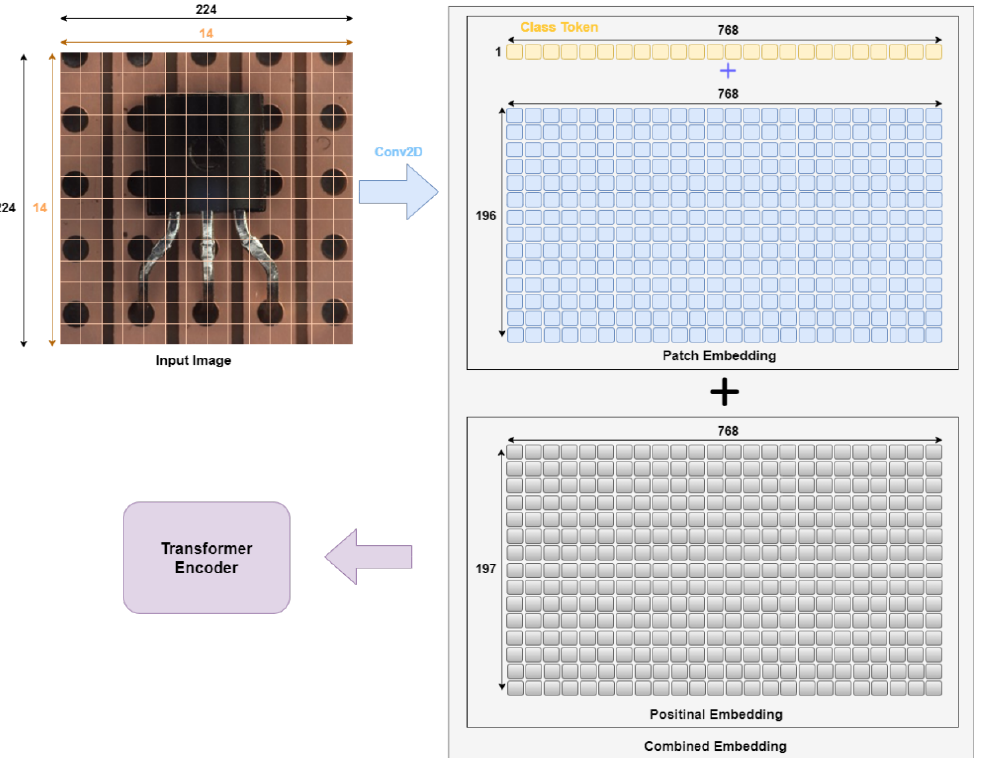
Figure 3. ViT embedding: if the input image size H, W is 224, and the channel number is 3, then the patch size is 16. When patch embeddings are applied, this is a sequence of 196 × 768 dimensions of the tensor. Subsequently, if a class token is added, it has a sequence of 197 × 768. It is then combined with a position embedding function with the same 197 × 768 dimension, and then entered into the